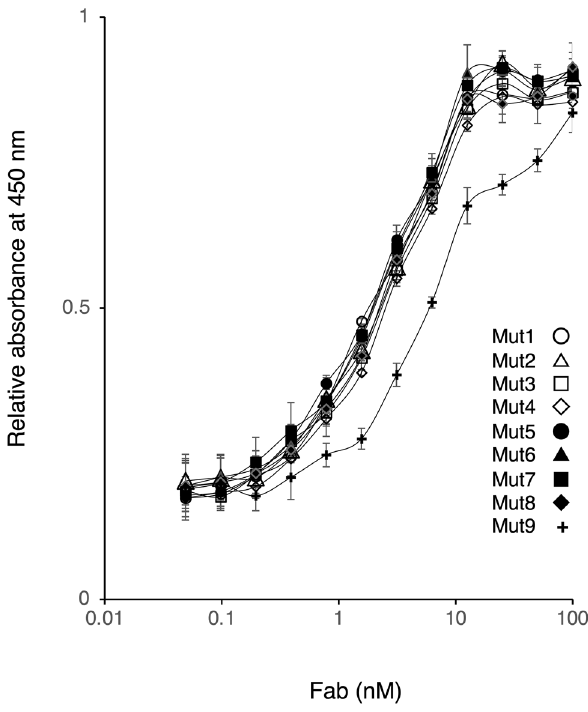
Figure 3. The antigen-binding activity of intermolecular SS mutants. The ELISA plate was coated with TNFα, followed by addition of intermolecular SS mutants at various concentrations. Anti-human Fab conjugated with horseradish peroxidase polyclonal antibody was used for evaluating the antigen-binding activity. The absorbance was measured at 450 nm using microplate spectrometer.